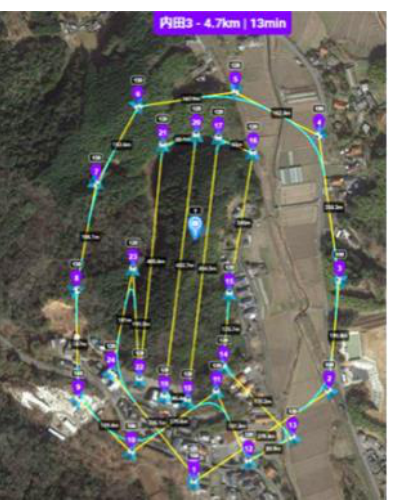
Photo 1. UAV route map for Akamura tomb